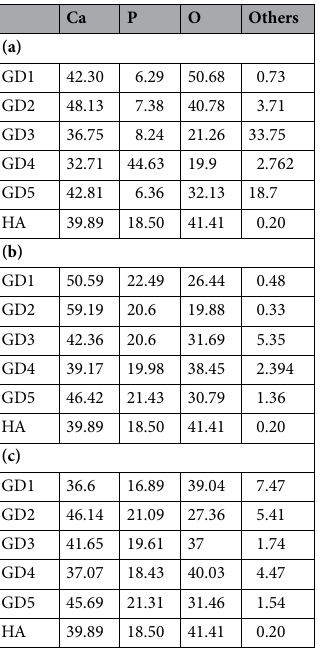
Table 2. Proportional chemical composition of pulp, dentine and enamel, obtained at EDS equipment, last line of each table indicates expected HA composition. (a) Pulp. (b) Dentine. (c) Enamel.